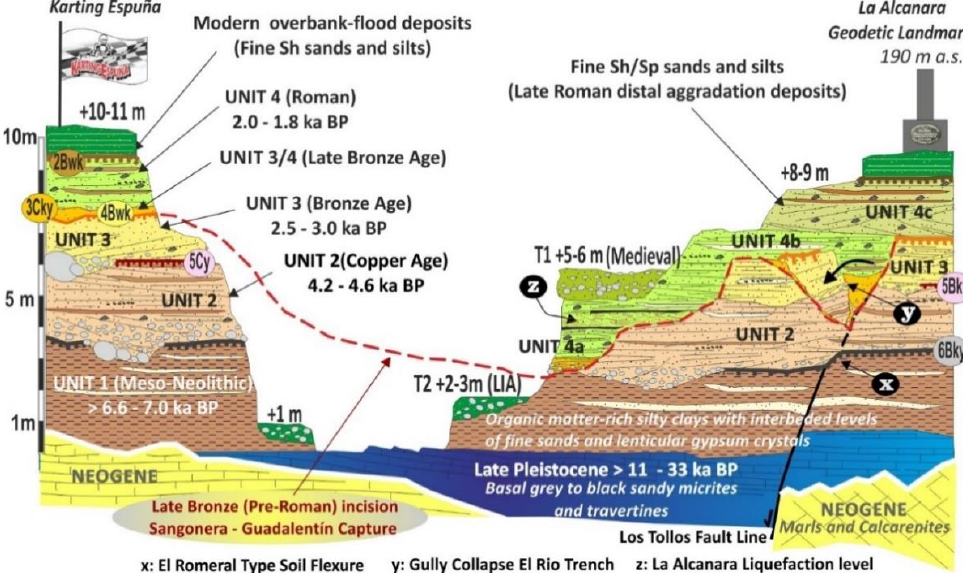
Figure 8. Synthetic cross-section for the Holocene sequence of the Guadalentín Basin (Murcia) studied in this paper. Left margins illustrate main features and overall radiocarbon chronology of the Karting Espuña profile studied in this work. Right margin expose the main sedimentary, pedogenic and paleoseismic features in close locations studied by other authors such as (a) 5Bky and 6Bky soil horizons reported by Calmel Á vila (2000a) and numbered (5, 6) following the sequence of pedogenic cycles differentiated in this work; (x) fault flexure affecting to the Meso-Neolithic soil at El Romeral Section reported by Calmel-Á vila 2007[43]; (y) Paleo-Gully collapse of the Late Bronze Age buried by sediments of the Roman period recorded at the Rio Trench [17]; (z) liquefaction level of the Roman period reported at La Alcanara [11,19].